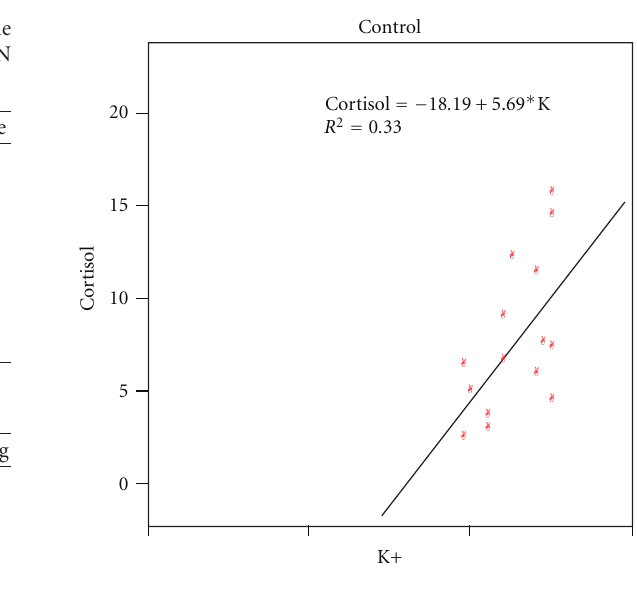
Figure 2: Correlation between potassium (K + ) and cortisol.